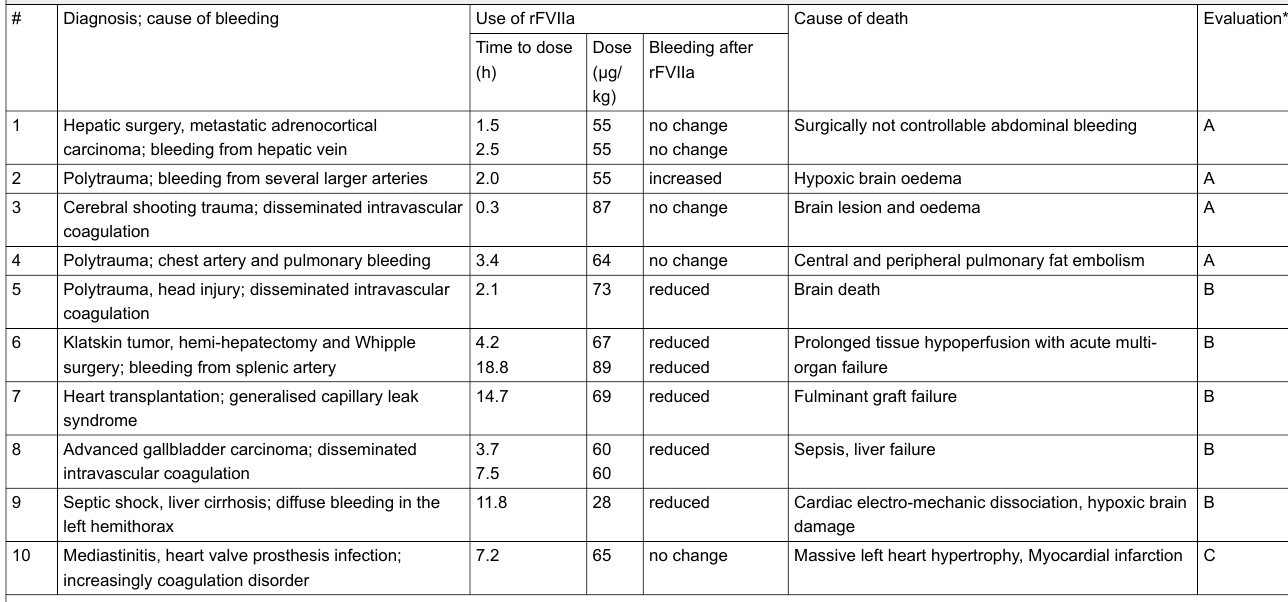
Use of rFVIIa# Diagnosis; cause of bleeding Cause of death Time to dose Dose Bleeding after (h) (μg/ rFVIIa kg)